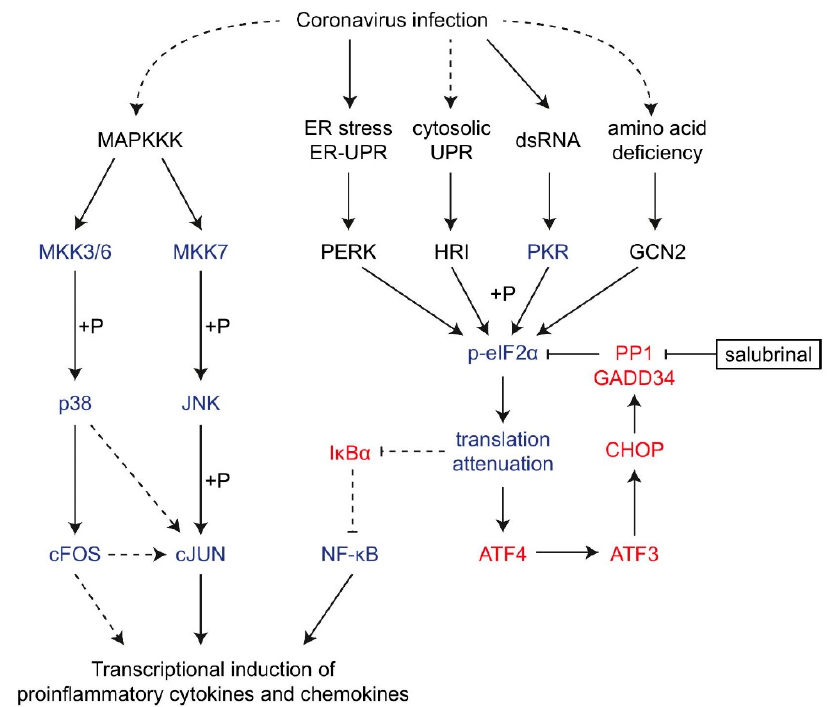
Figure 7. Diagram illustrating the current working model. The working model showing the induction of proinflammatory cytokines and chemokines by integrated stress response and AP-1 family proteins during coronavirus infection. Pointed and blunt arrows denote activation and suppression, respectively. Dotted lines denote processes that are not fully characterized. “+P” denotes phosphorylation.